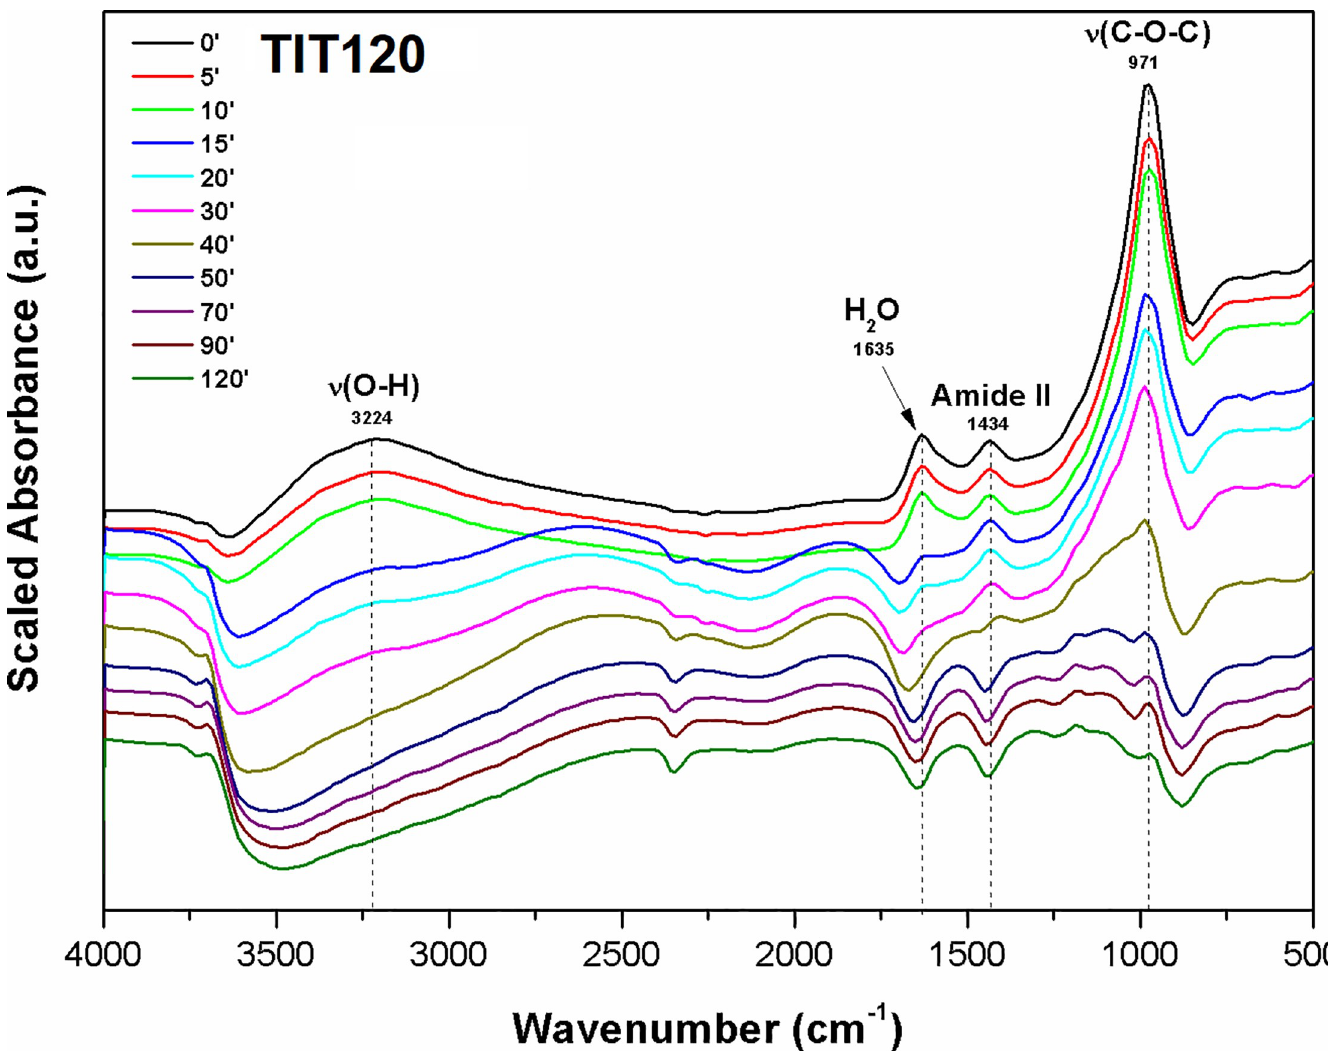
Fig 13. DRIFTS spectra of pirarubicin interaction with the TiO 2 surface (TIT120).